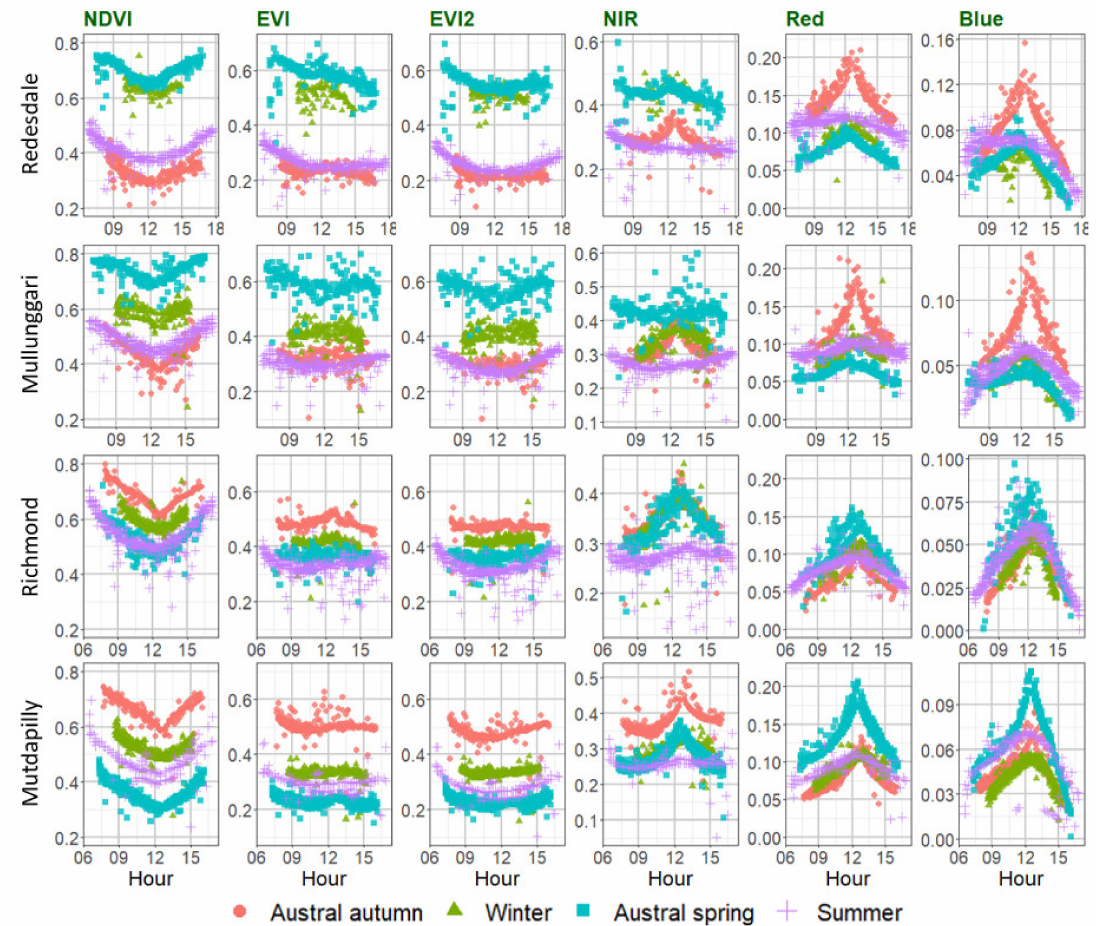
Figure 8. Diurnal patterns of AHI spectral reflectances and vegetation indices during four seasonal grass growing periods and across the four grassland sites. These included austral autumn (end of March), winter (July), austral spring (late September), and early summer (December). A pronounced hotspot e ff ect was observed mid-day near the austral autumn equinox period (end of March) and the austral spring equinox period (late September) at all grassland sites, when